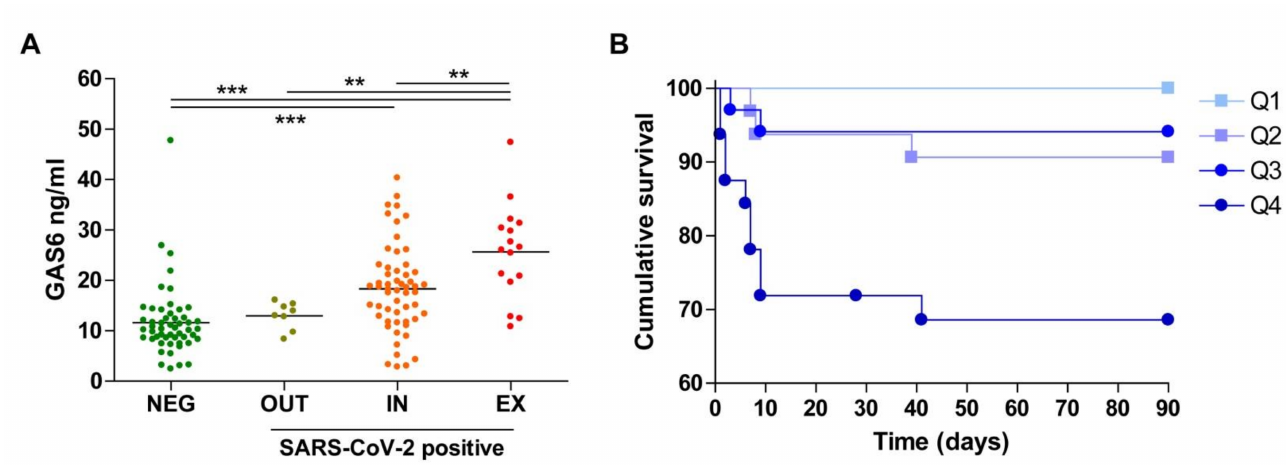
Figure 1. Plasma growth arrest-specific factor 6 (GAS6) concentration in consecutive emergency patients and survival curves related to quartile GAS6 values. ( A ) GAS6 plasma concentration was measured in patients (NEG, negative test for SARS-CoV-2; OUT, positive test not requiring hospital admission; IN, positive test and admission survivors; EX, positive test, deceased) and compared using one-way Anova. **, p < 0.01; ***, p < 0.001. ( B ) Survival plot of all patients divided by GAS6 concentration quartile at admission. Lowest quartile (Q1), second quartile (Q2), third quartile (Q3), and highest quartile (Q4). The GAS6 survival curves were different in a logrank test ( p < 0.0001) and the Q4 survival was significantly different to all other curves ( p = 0.004 vs. Q3; p = 0.017 vs. Q2 and p < 0.001 vs.